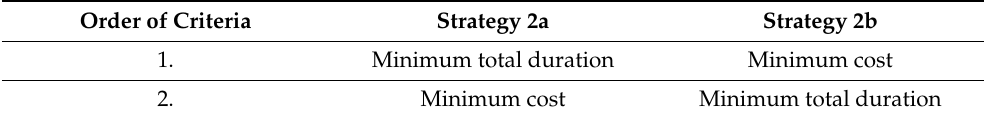
Table 1. Order of optimization criteria for different versions of Strategy